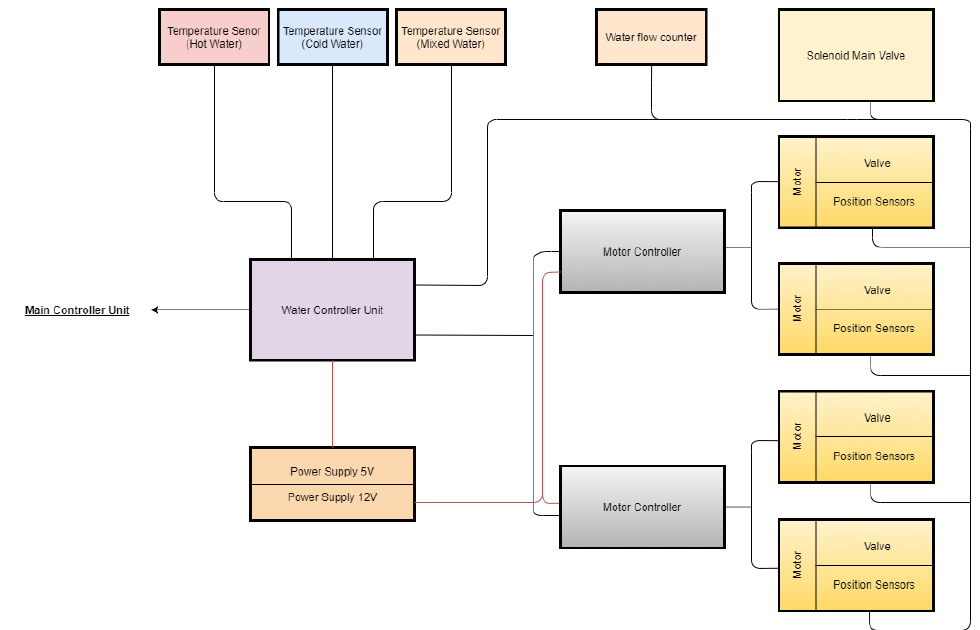
Figure 6. A concept of the water controller unit of the interactive shower panel.